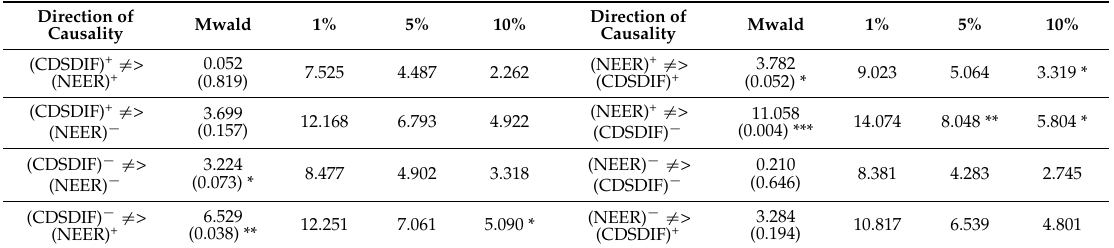
Table 3. Hatemi-J and Roca [24] asymmetric causality test results.